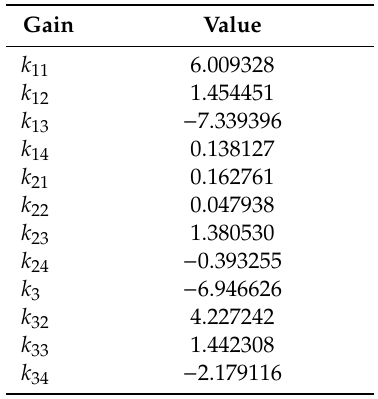
Table A4. Gains of the observer for studies presented in Section